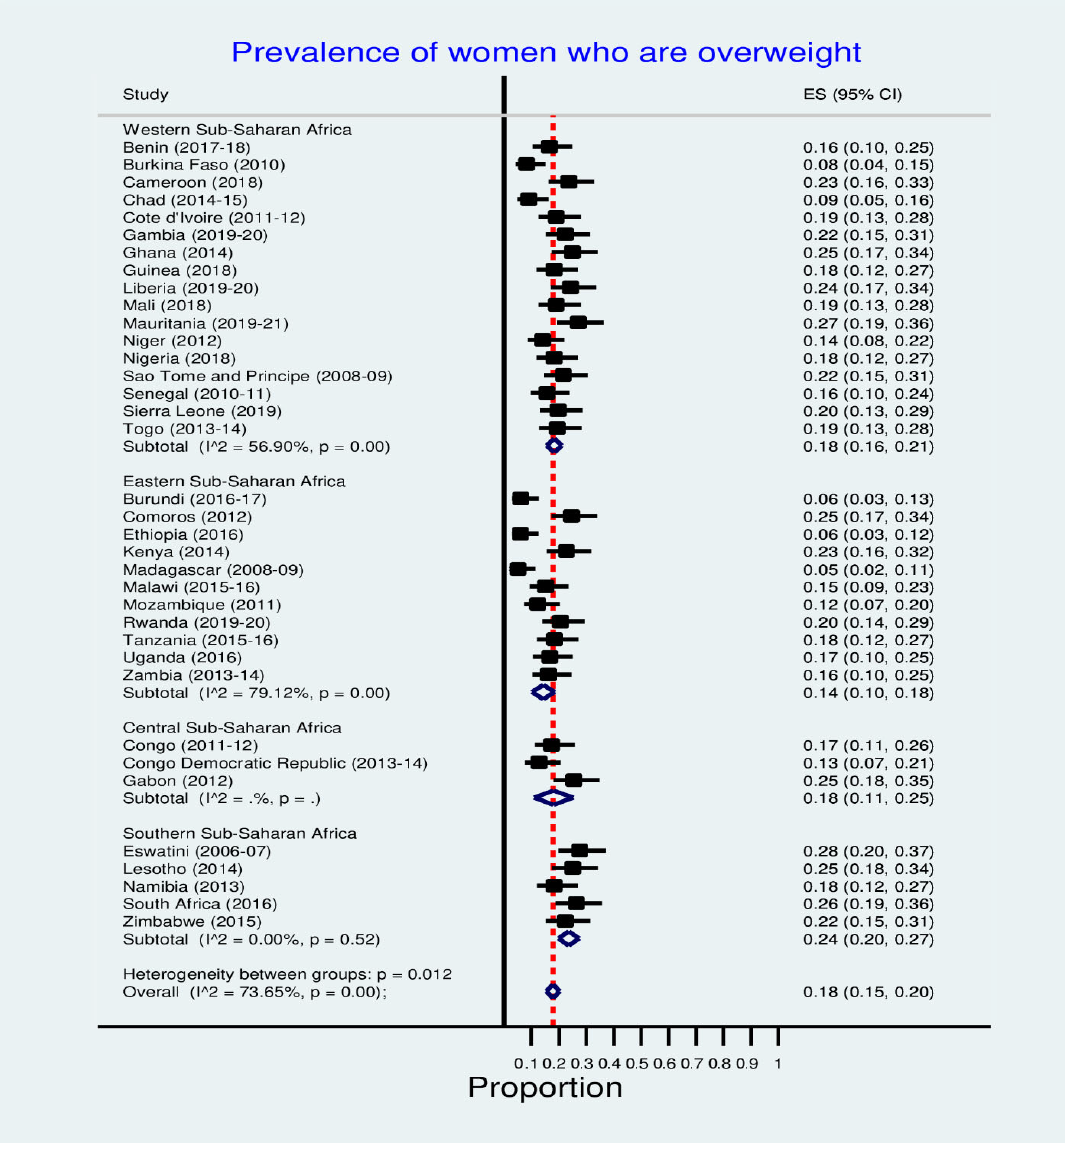
Figure 2. Prevalence of overweight among women in SSA